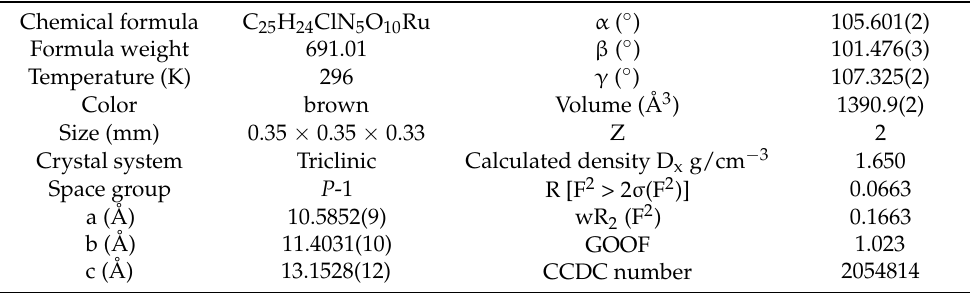
Table 1. Crystal structure parameters of Ru-Lbpy 2 complex